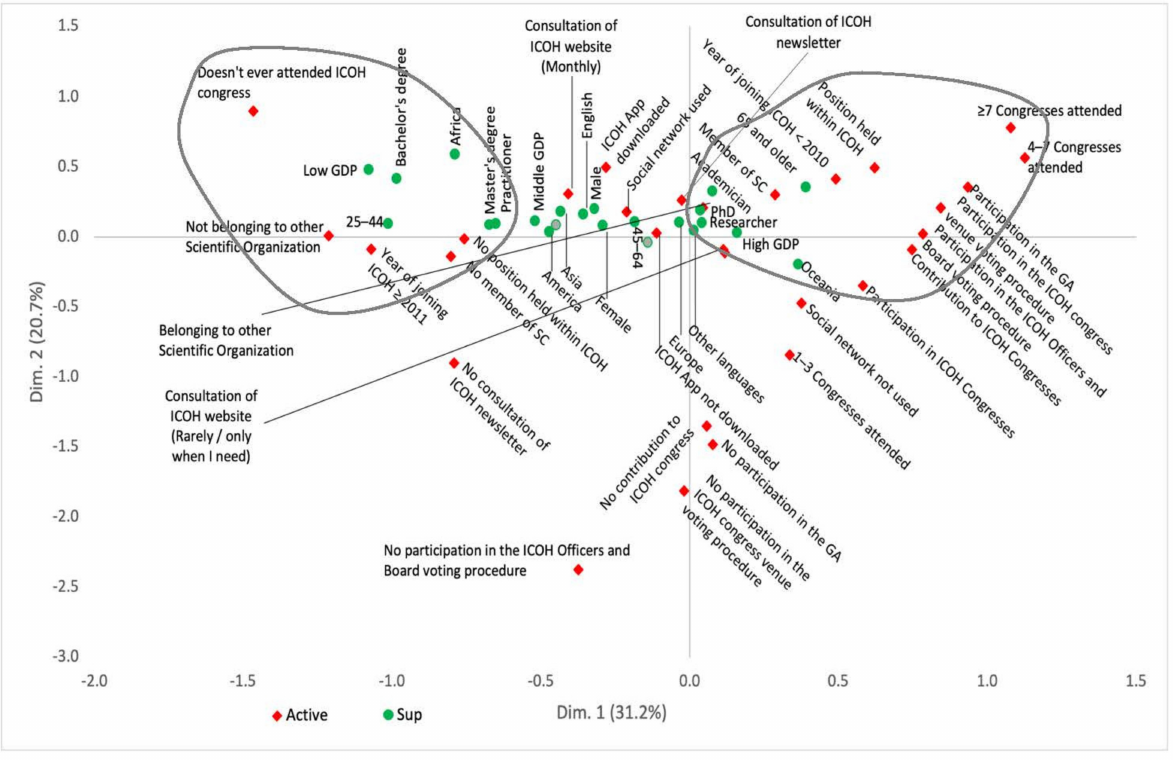
Figure 1. Multiple correspondence analysis map (projections on the first 2